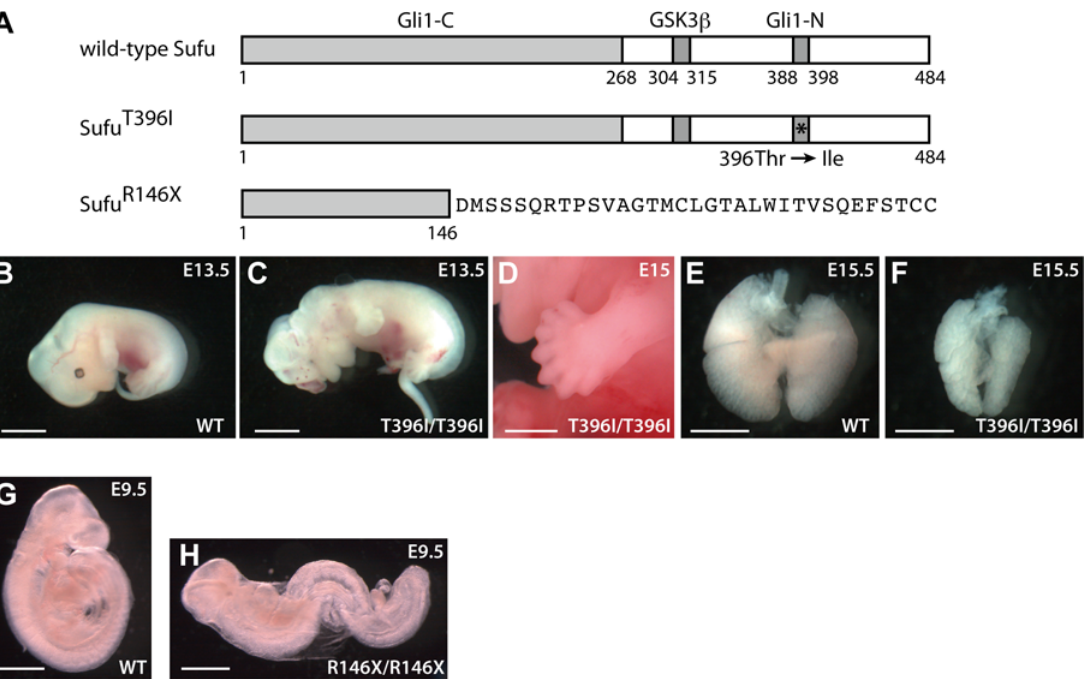
Fig 1. Identification of novel Sufu mutants. ( A ) Schematic diagrams of the mouse Sufu protein. The numbers refer to amino acid residues. Filled boxes indicate binding domains with GSK3 β [21] and the C- and N-terminal regions of Gli1 [26]. An asterisk marks the position of a 1-base substitution that results in a change of Thr 396 to Ile (T396I). Sufu R146X is a 1-base pair deletion in Sufu , leading to premature termination of the protein product after addition of an aberrant 33 amino acid stretch at the C terminal when translated. ( B, C ) Wild-type and Sufu T396I/T396I embryos at E13.5. Scale bar, 4 mm. ( D ) Limb phenotype of Sufu T396I/T396I at E15. Scale bar, 2 mm. ( E, F ) Lungs of wild-type and Sufu T396I/T396I at E15.5. Scale bars, 2 mm. ( G, H ) Wild-type and Sufu R146X/R146X embryos at E9.5. Scale bars, 1 mm. Homozygous embryos died at approximately E9.5 and exhibited an open brain and failure to undergo embryonic turning, characteristics identical to those reported in Sufu knockout embryos